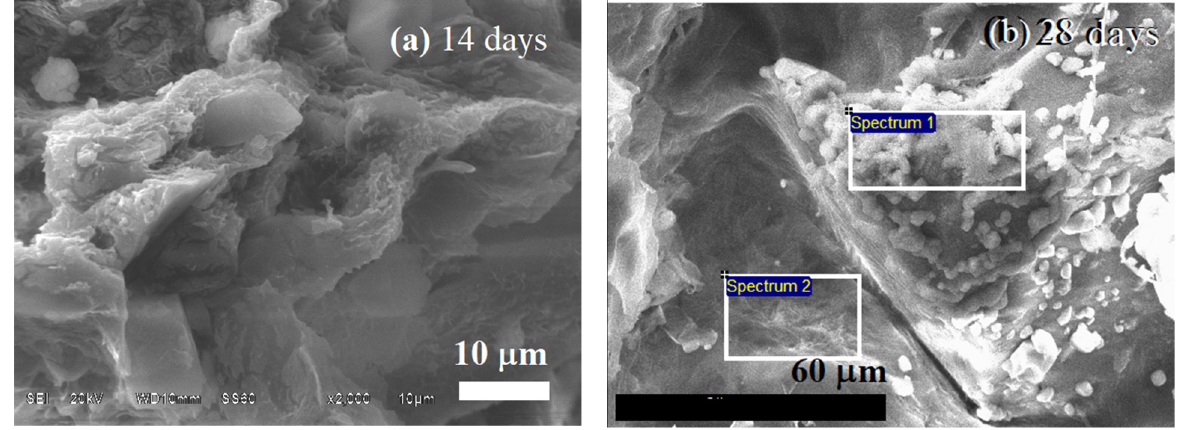
Figure 9. EDS analysis for BG70-PLA30 after ( a ) 14 and ( b ) 28 days of immersion in SBF.